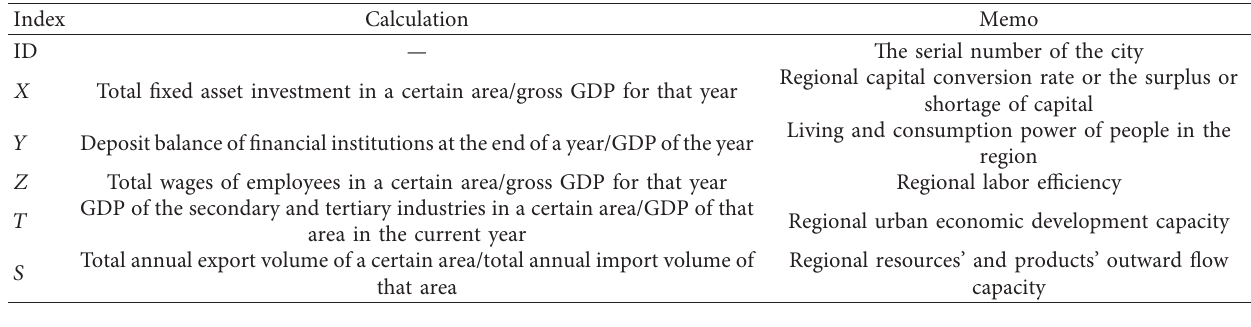
Table 2: Index system and data composition of urban geoeconomic